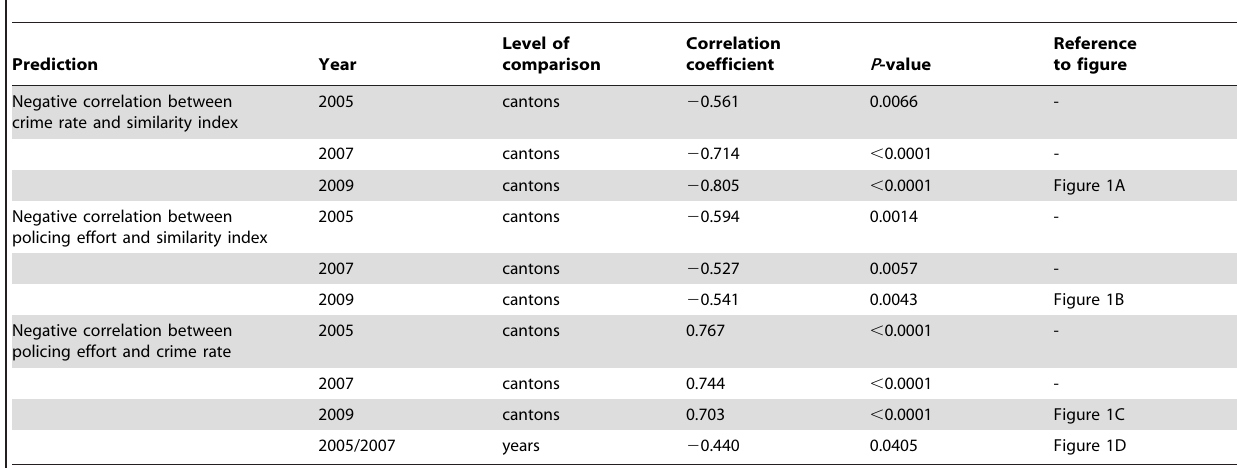
Table 2. Predictions of evolutionary policing theory [20] and the corresponding empirical tests using data from the 26 cantons of Switzerland in 2005, 2007, and 2009.